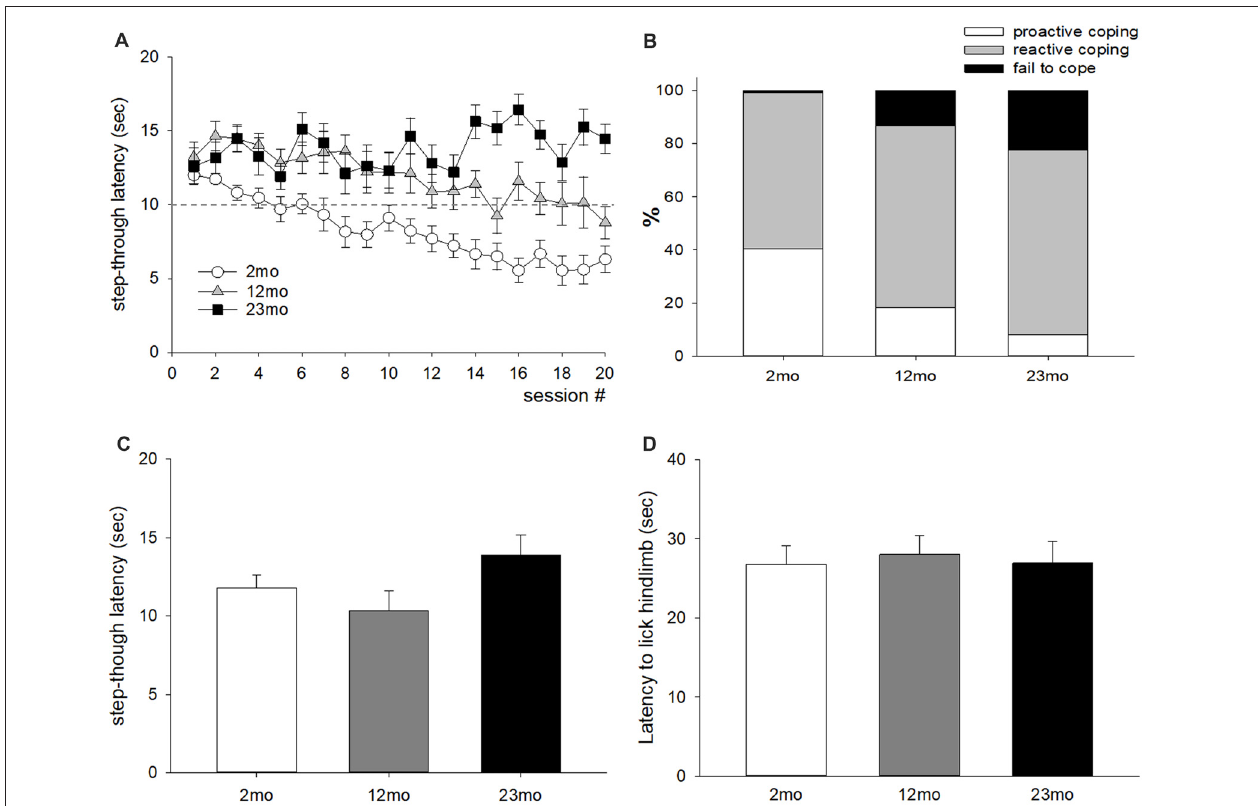
FIGURE 1 | Age-related differences in coping style in the active avoidance test. (A) Step-through latency throughout 20 test sessions. Repeated measures ANOVA showed a significant training (within factor) effect ( F ( 19,874 ) = 4.74, p < 0.001), age (between factor) effect ( F ( 2,46 ) = 24.6, p < 0.001), and training by age interaction ( F ( 38,874 ) = 3.28, p < 0.001). Post hoc pairwise comparisons showed that step-through latency was longer for 12-month-old mice than 2-month-old mice ( p < 0.001), and for 23-month-old mice than 12-month-old mice ( p = 0.04). The dashed line indicates the time for electric foot shock presentation. (B) Percentiles of avoid (escape before shock presentation), escape (escape during shock presentation), and fail to escape during active avoidance training; these behaviors were considered proactive, reactive and fail to cope, respectively. A chi-square test of independence revealed a significant relationship between age and coping response ( χ 2 ( 4 ) = 159.6, n = 980, p < 0.001). Proactive coping response decreased with increasing age. (C) Seventy-two hours delayed measurement of step-through latency. There was no significant difference between age groups. (D) Latency to lick the hind limb in the hot plate test. There was no significant difference between